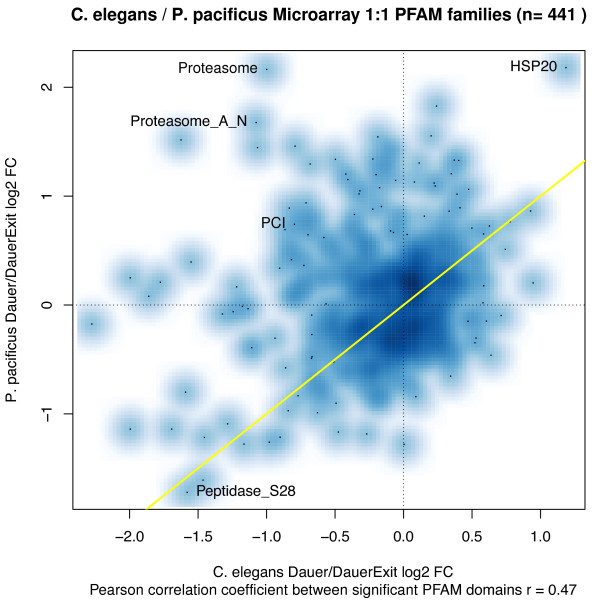
Log2 fold changes of median PFAM gene expression levels inP. pacificusandC. elegans. All genes on the microarrays were stratified by PFAM domain annotation into partially overlapping gene families with at least 5 members. A positive log2 fold change indicates that the corresponding genes were up-regulated in the dauer stages in comparison to the dauer exit time point.